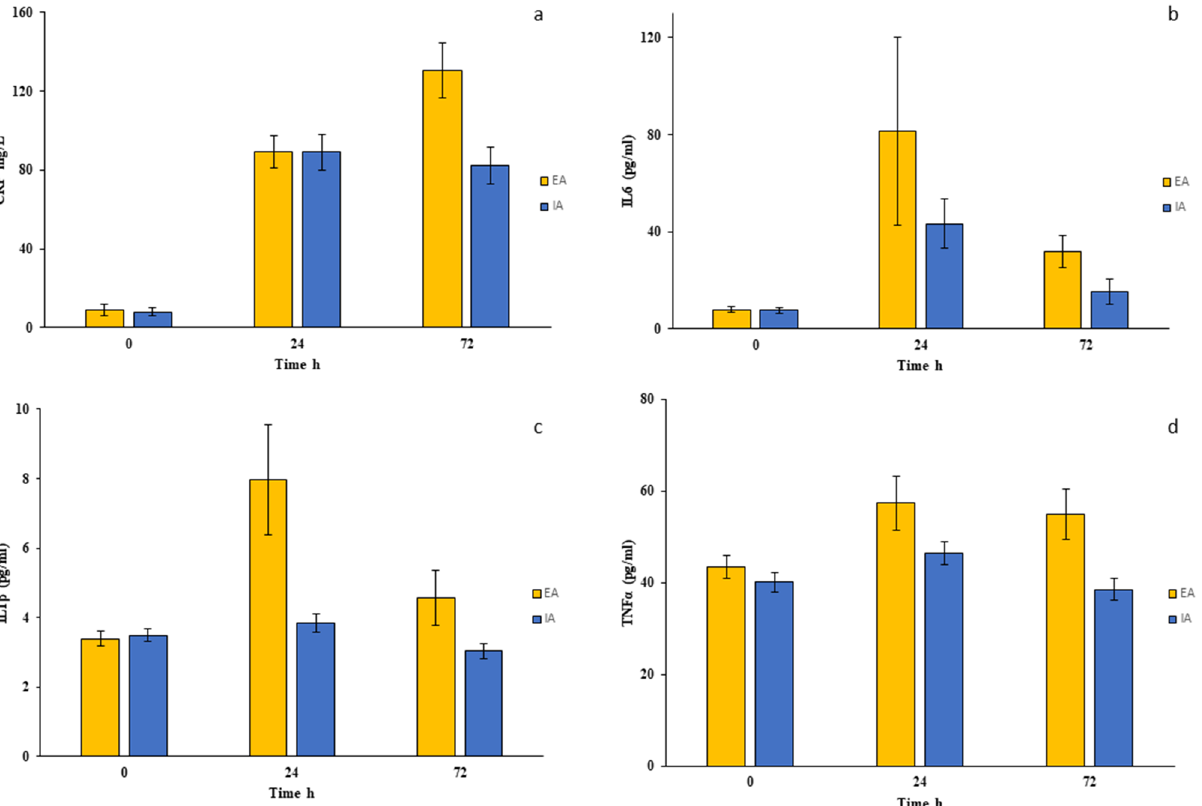
Figure 1. Proinflammatory response after EA and IA surgeries in colon cancer patients. Serum CRP ( a ), IL-6 ( b ), IL-1β ( c ) and TNFα ( d ) levels were evaluated in colon cancer patients undergoing EA or IA anastomosis in laparoscopic right hemicolectomy surgeries 0, 24 and 72 h postsurgery. Results are shown as means ± SD. Statistical analysis was performed using Kurskal Wallis test and Bonferroni post-test